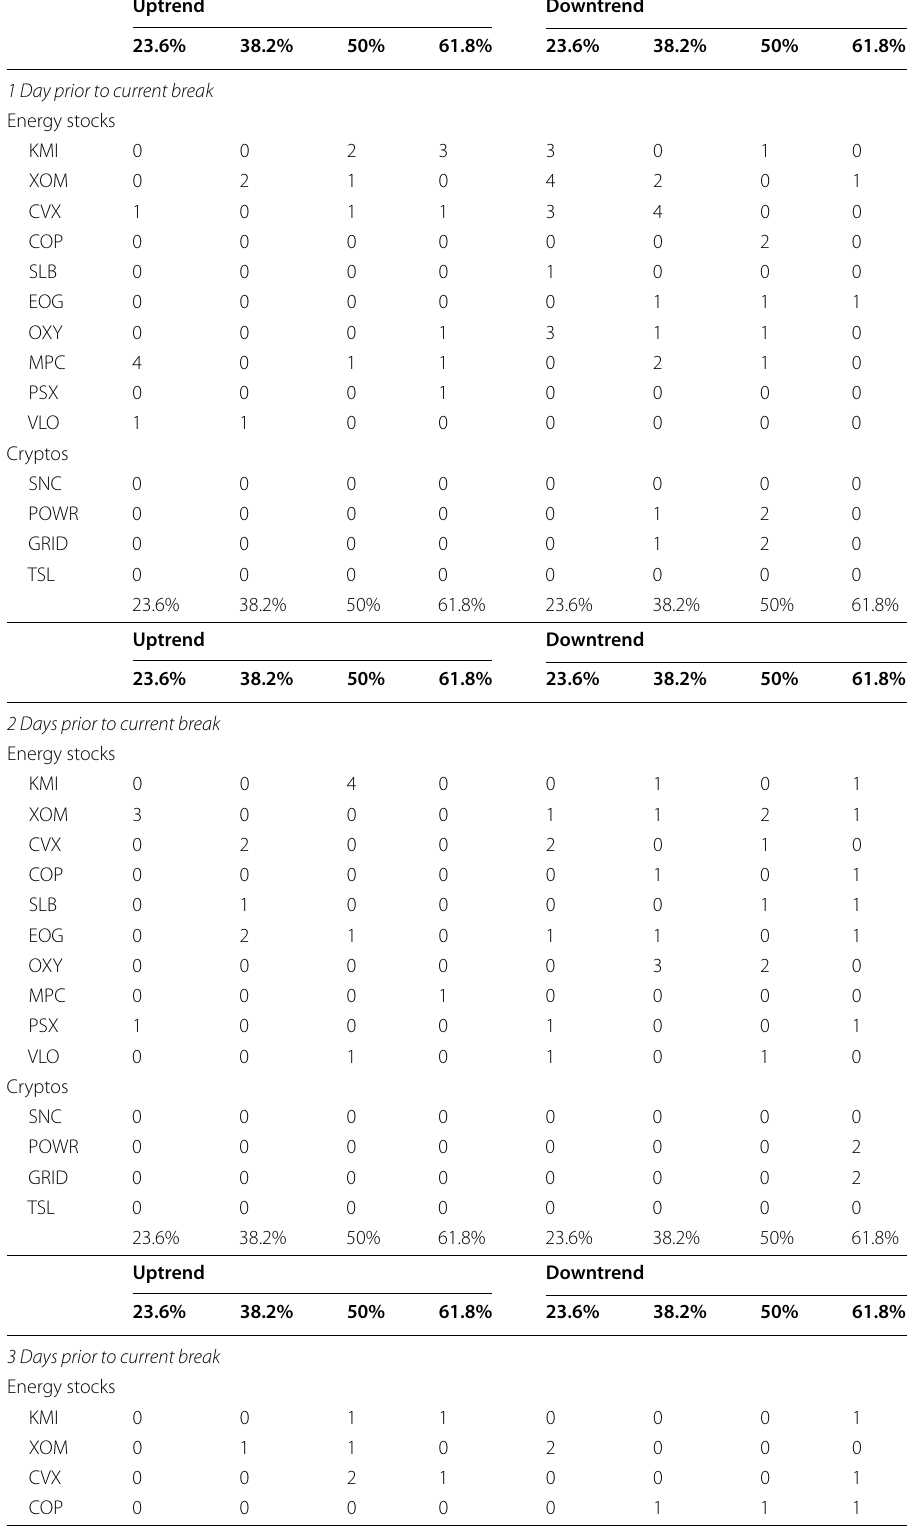
Table 2 Behaviour of price